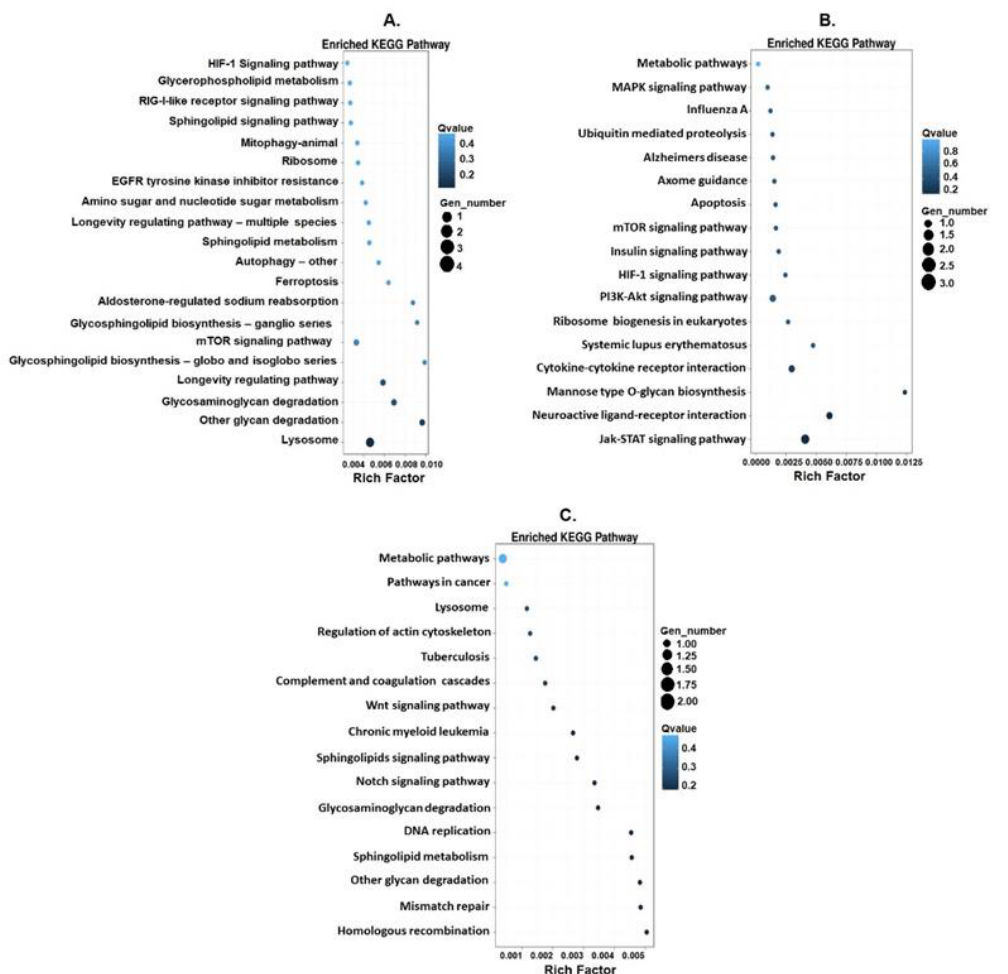
Figure 7. KEGG pathway functional enrichment of DEGs. The x-axis shows the enrichment factor. The y-axis shows pathway name. Point size indicates DEG number (the bigger dots refer to larger amounts); the larger the value, the more significant the enrichment. The color represents the q-value (high: white, low: blue), a lower q-value indicates a more significant enrichment. ( A ) Comparison between Gc and Gs1, ( B ) comparison between Gs1 and Gs5, ( C ) comparison between Gc and Gs5.